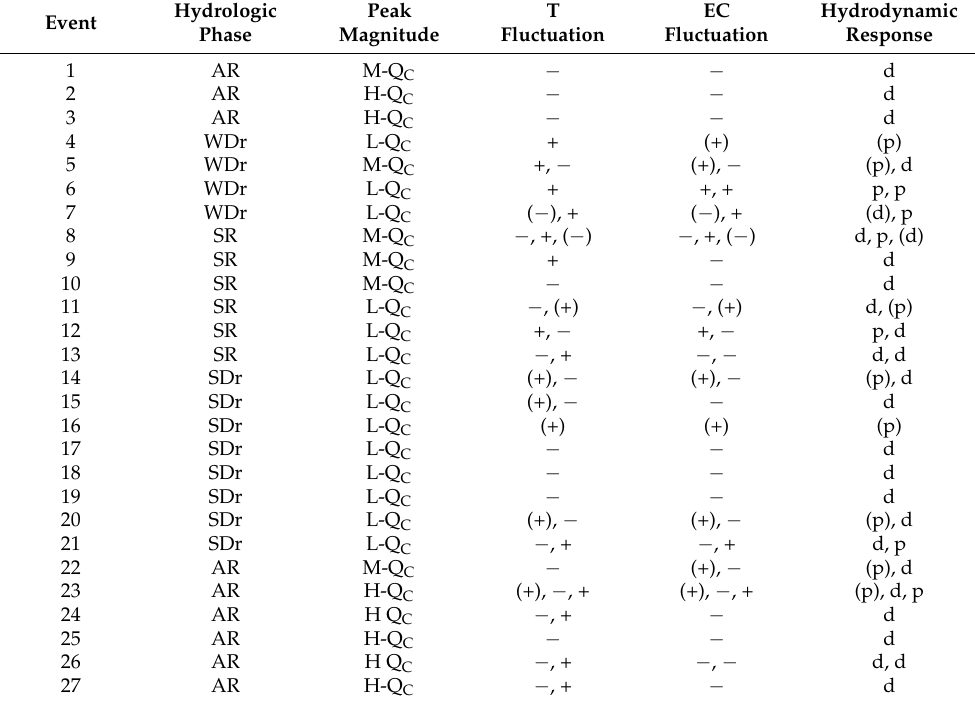
Table 4. Analyzed storm hydrographs. AR = autumn recharge; WDr = winter drought; SR = spring recharge; SDr = summer drought; L/M/H-Q C = Low/Medium/High peak magnitude (L − Q C < 4 m 3 /s, 4 m 3 /s ≤ M − Q C ≤ 8 m 3 /s, and H − Q C > 8 m 3 /s); + = positive peak/increase; − = negative peak/decrease; d = dilution; p = piston flow (the T/EC fluctuation and the hydrodynamic response